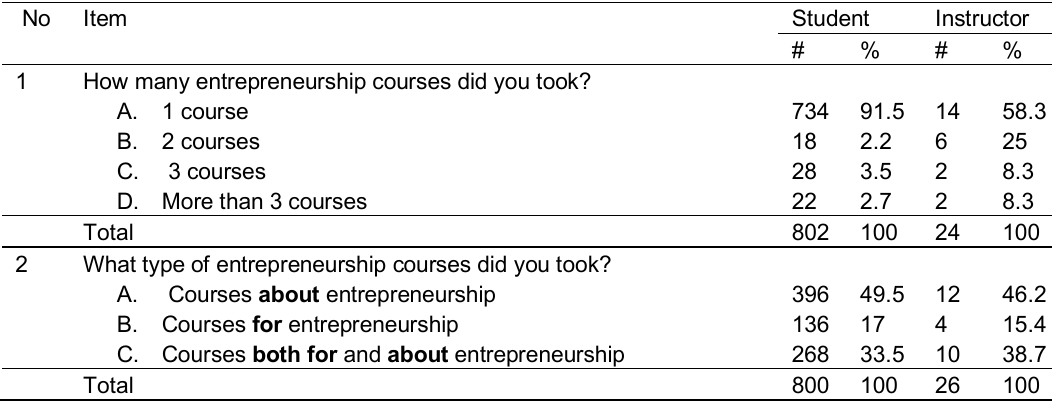
Table 4: The type of entrepreneurship courses students